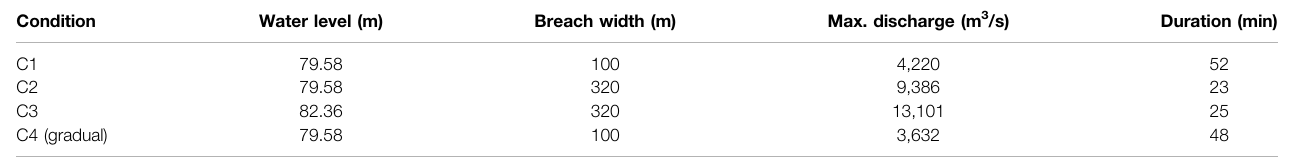
TABLE 2 | Flood parameters under different conditions.